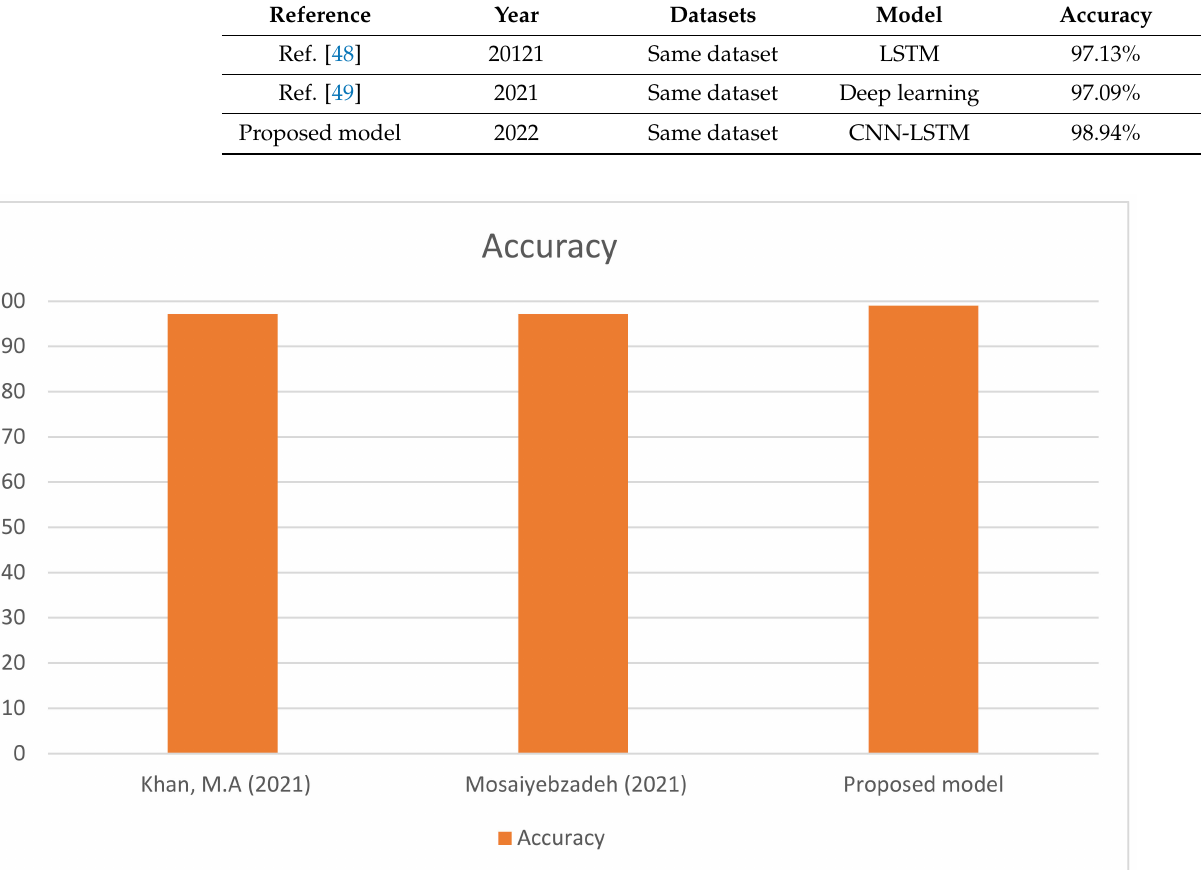
Figure 12. Comparison of proposed CNN-LSTM against security systems